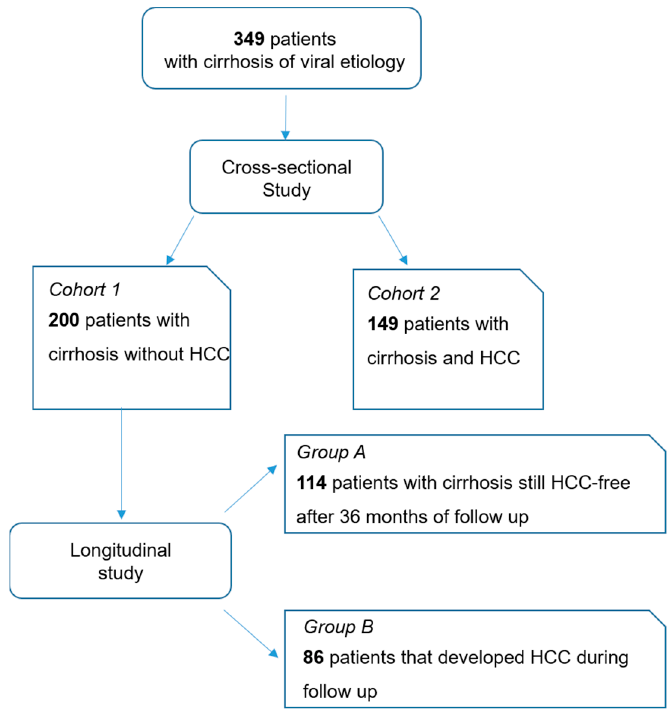
Figure 1. Flow chart of the study. Abbreviations—hepatocellular carcinoma (HCC). Median serum values of AFP, PIVKA-II and GPC-3 were significantly di ff erent between cirrhotic Table 1. Characteristics of the patients included in the study according to the diagnosis of hepatocellular carcinoma.